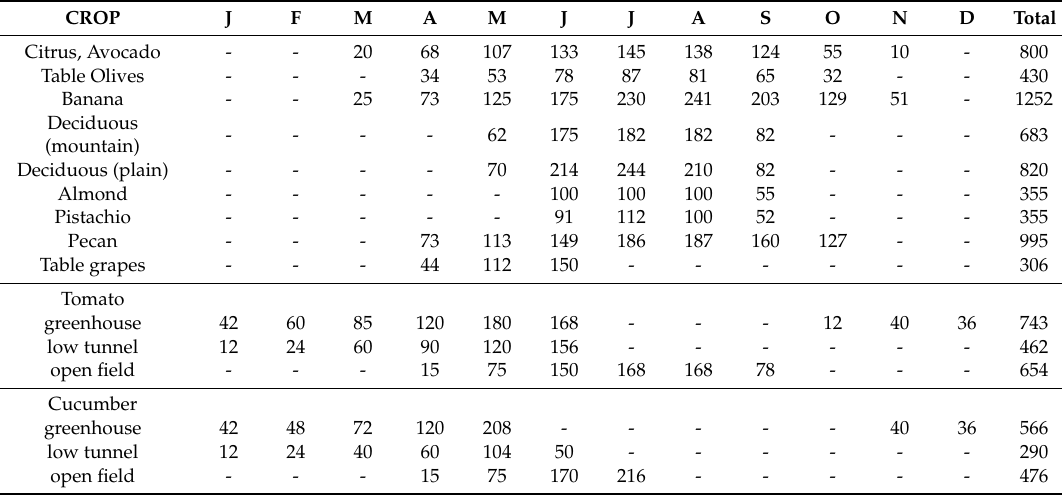
Table 1. Monthly and yearly estimated evapotranspiration requirements (mm) for several crops in Meditteranean climatic conditions, as is the case of Cyprus. Data adapted from